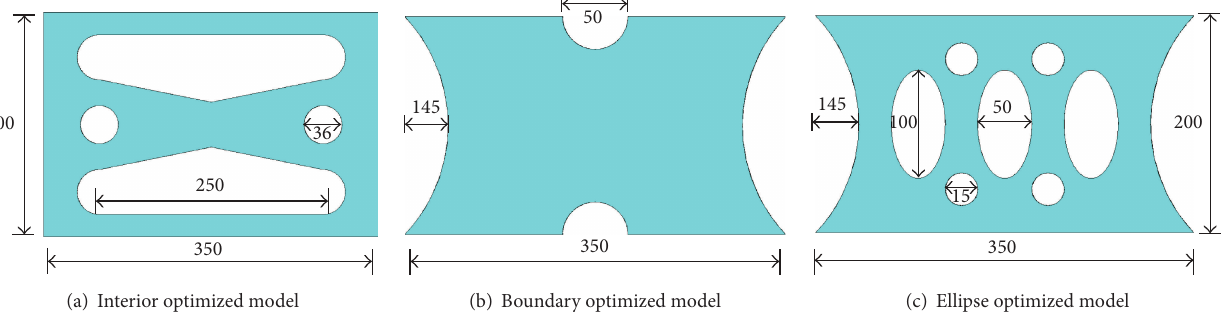
Figure 12: Final optimized size (unit: mm).